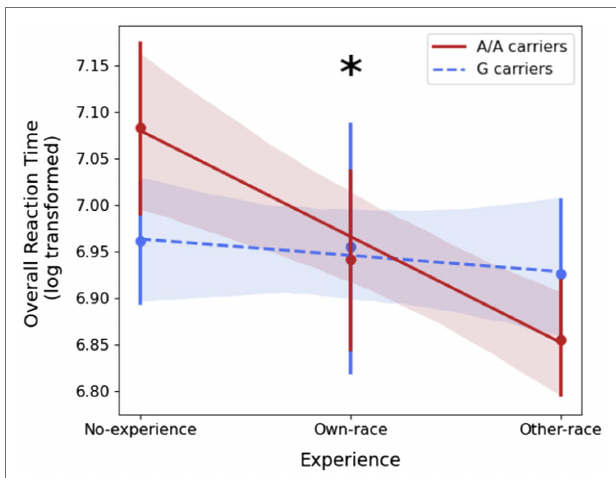
FIGURE 3 | Regression lines representing the association between ORT and Experience for the two Genetic Groups, resulting from the multiple linear regression analysis. Circular markers indicate the mean, vertical bars indicate the 95% confidence intervals. Shaded areas represent the confidence intervals for the regression estimated by bootstrap. The asterisk indicates that the correlations between ORT and Experience for the two Genetic Groups are statistically significant ( p <